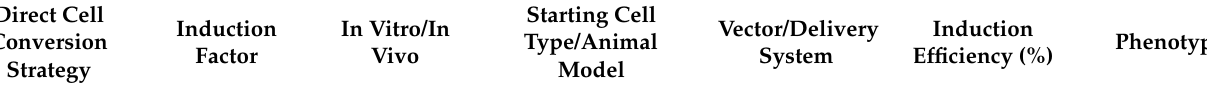
Table 1. The Common Bench Approaches for Direct AtN Conversion and